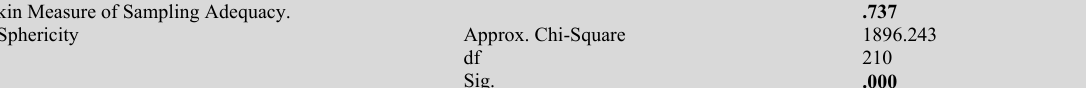
KMO and Bartlett's Test Kaiser-Meyer-Olkin Measure of Sampling Adequacy.